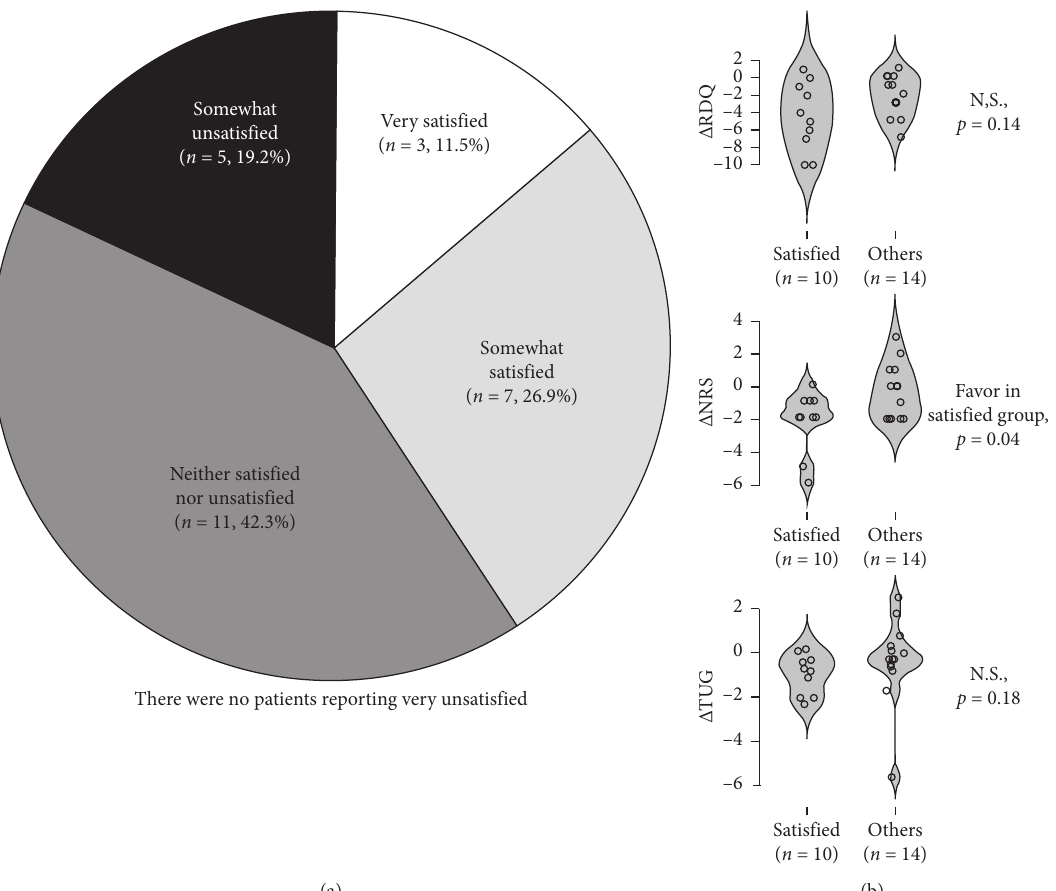
Figure 4: (a) Satisfaction rating by participants in the TAU +OLP group. (b) Difference in outcomes at week 12 between satisfied (Very Satisfied and Somewhat Satisfied) and other (Neither Satisfied nor Unsatisfied and Somewhat Unsatisfied) group. Outcome values are changes from the baseline value at week